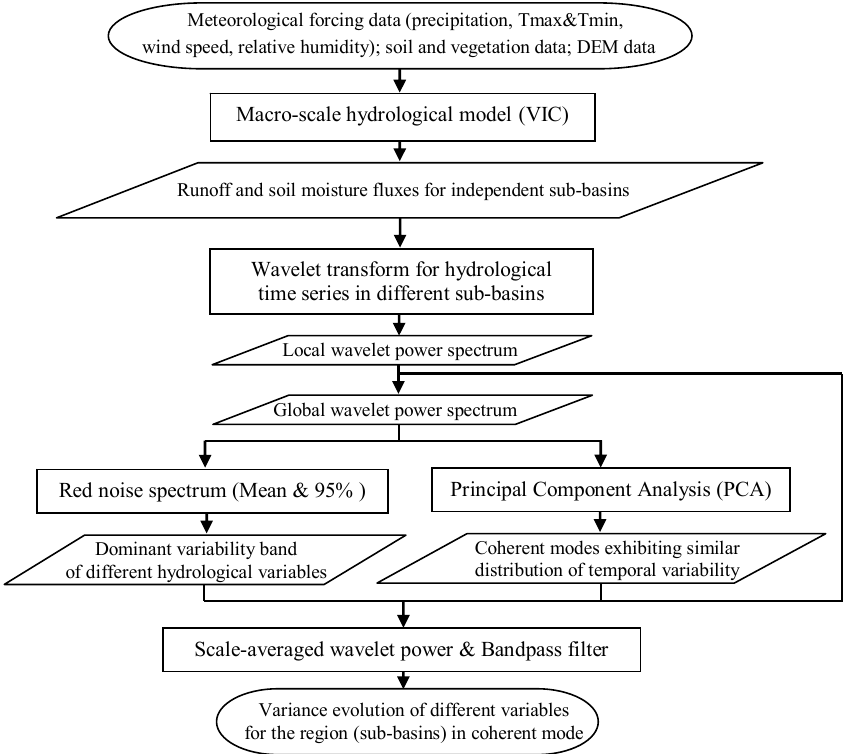
Fig. 5. The flowchart of regional variance evolutions for different hydrological variables.